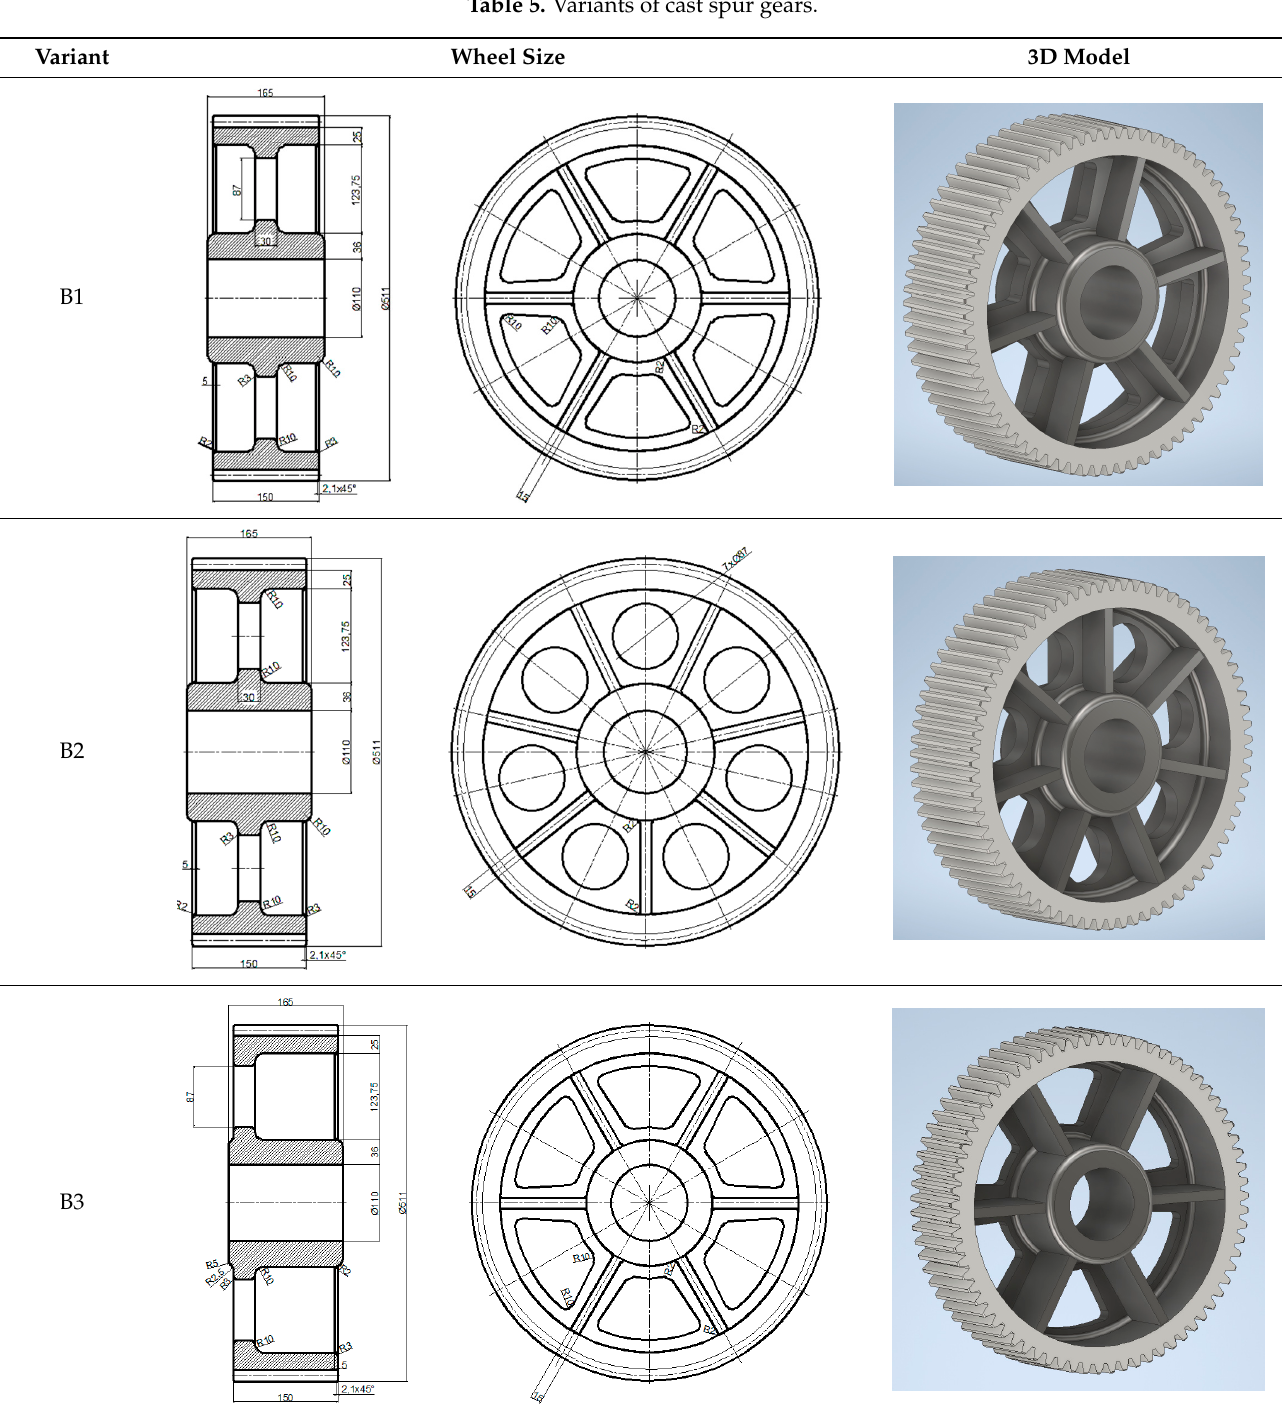
Table 5. Variants of cast spur Table 5. Variants of cast spur gears. Table 5. Variants of cast spur gears. Table 5. Variants of cast spur gears. Table 5. Variants of cast spur gears. Table 5. Variants of cast spur gears. Table 5. Variants of cast spur gears.